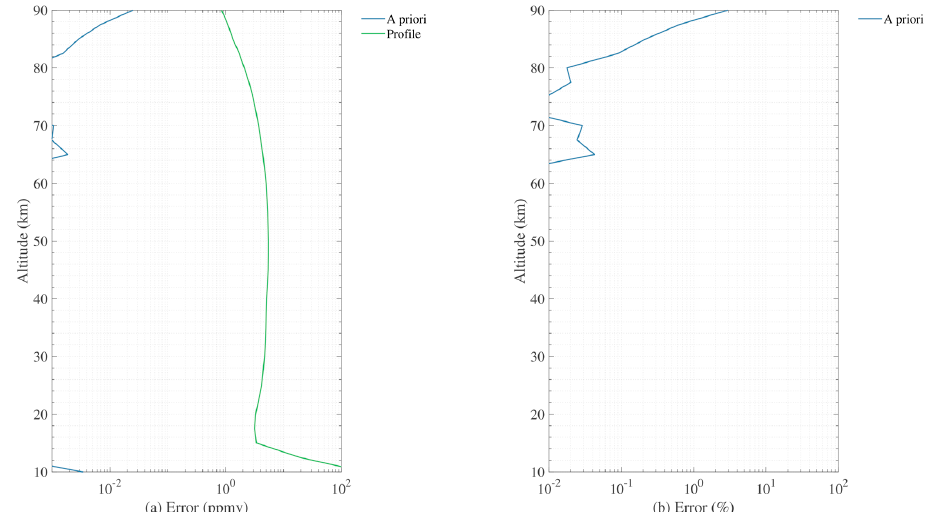
Figure 12. The H 2 O retrieval error induced by external error source: ( a ) absolute and ( b ) relative retrieval errors. The uncertainties assumed are summarized in Table 5.